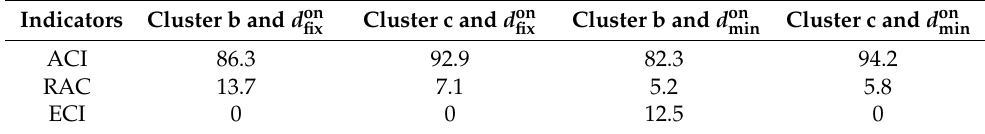
Table 1. Statistics of identification based on different clusters and signal-domain distances (%).